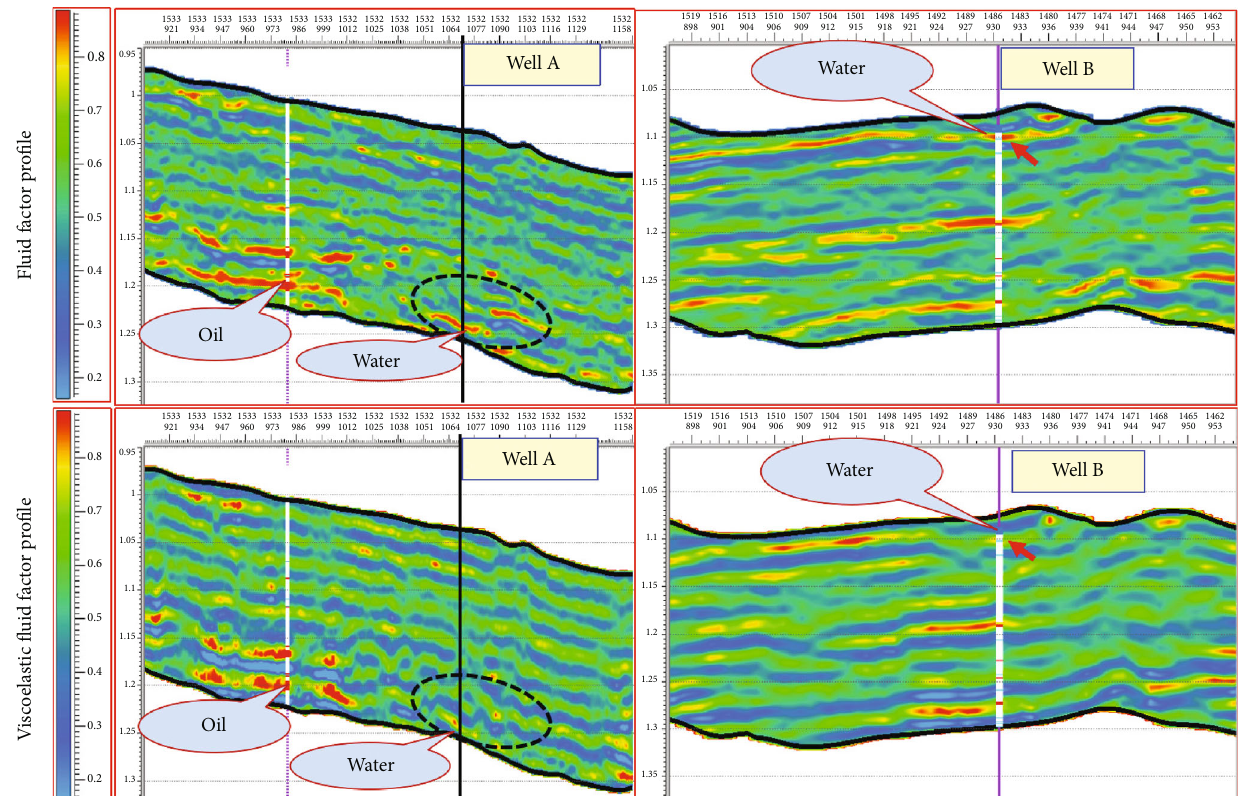
Figure 4: Fluid factor pro fi le compared with viscoelastic fl uid factor pro fi le of wells A and